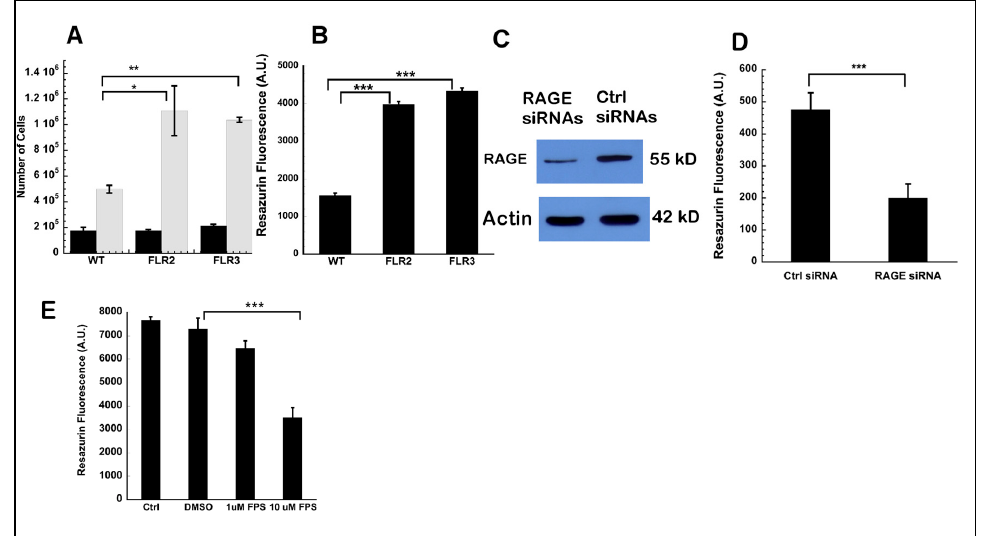
Figure 1. ( A , B ) RAGE expressing FLR2 and FLR3 Panc ‐ 1 cells have higher proliferation rates than WT Panc ‐ 1 cells. ( A ) Cell proliferation was assessed by Trypan blue exclusion assay. Black bars: number of cells at the time of seeding; gray bars: number of cells after a 48 h incubation. ( B ) Cell proliferation was assessed using resazurin fluorescence 48 h after cell seeding. ( C ) RAGE silencing reduces RAGE expression levels in FLR2 Panc ‐ 1 cells. FLR2 Panc ‐ 1 cells were transfected using RAGE specific siRNAs or control (Ctrl) siRNAs. ( D ) RAGE silencing reduces the proliferation of FLR2 Panc ‐ 1 cells. FLR2